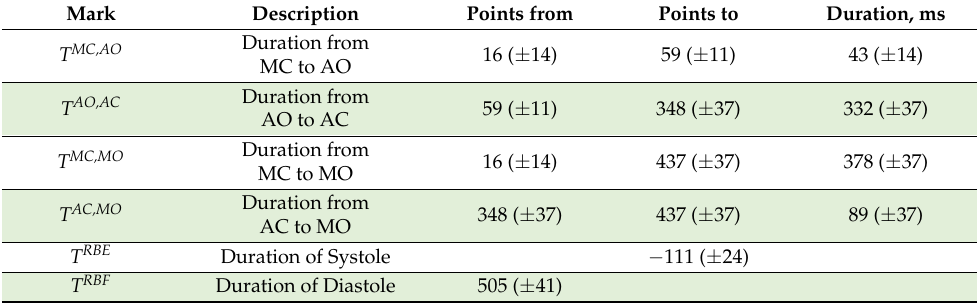
Table 1. Seismocardiogram artefacts fiducial points and duration rangers. Mark Description Points from Points to Duration, ms